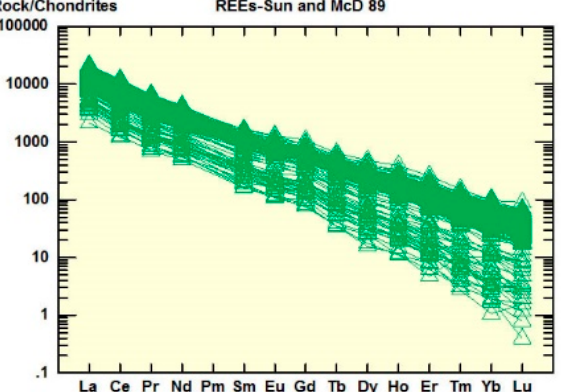
Figure 5. Distribution of REE in Khibiny apatite.